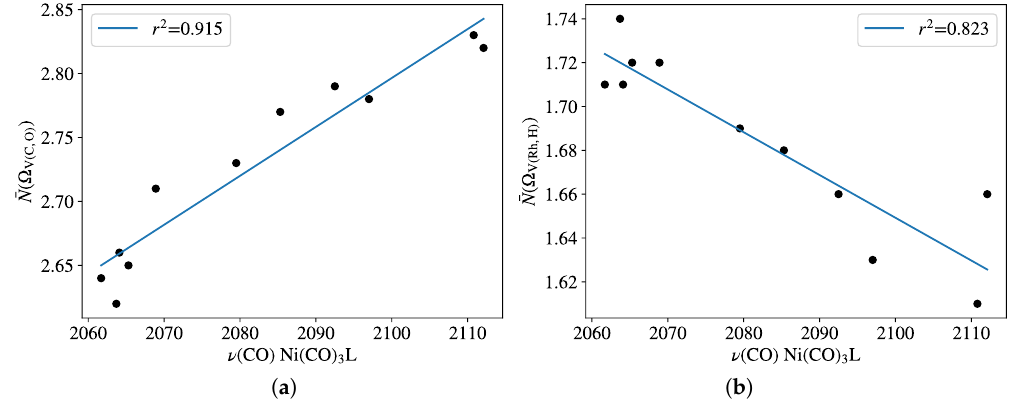
Figure 6. Population of ELF basins ( a ) V(C,O) and ( b ) V(Rh,H) for complexes HRhL 2 (CO) against Tolman’s parameters at the B97D3 level. Frequency values are given in Table